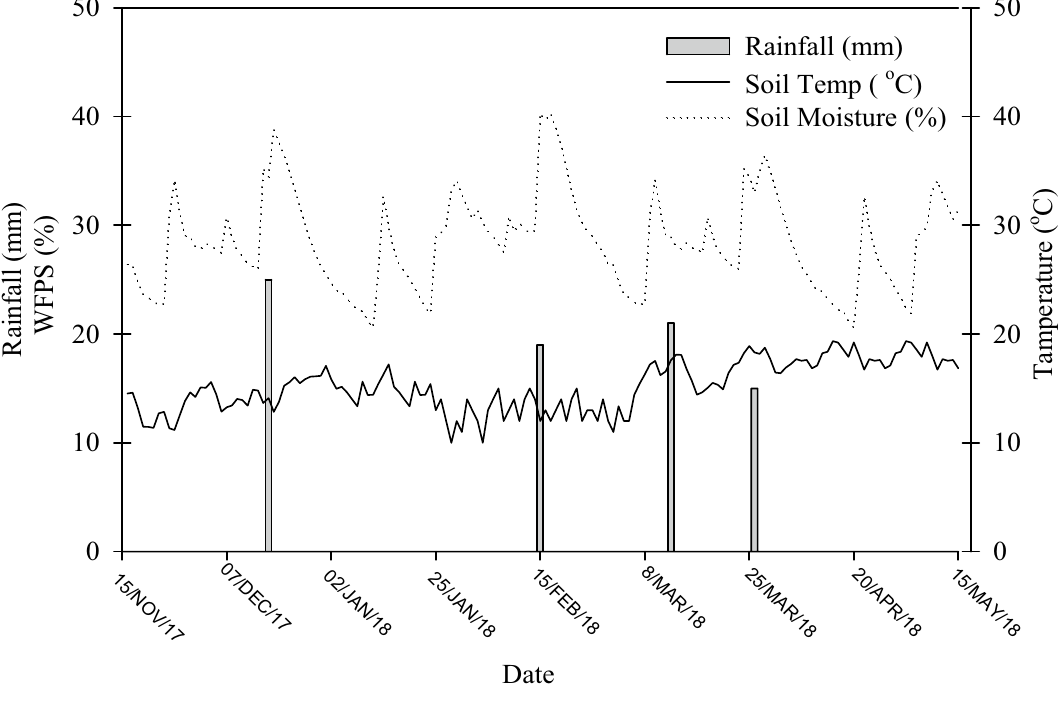
Figure 1. Soil temperature (0–10 cm depth) and moisture (water-filled pore space; WFPS) (0–10 cm depth) and monthly average precipitation during the experimental